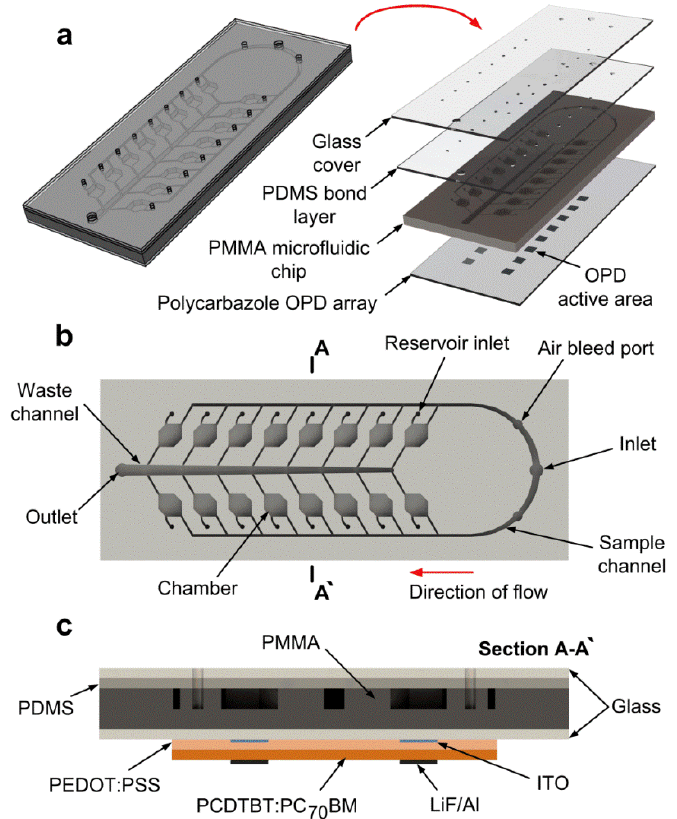
Figure 1. ( a ) Illustration of the multiplexed optical-biosensor platform integrating an array of polycarbazole OPDs to a hybrid microfluidic chip made of PMMA and PDMS. ( b ) Top view of the PMMA microfluidic substrate with ~30 mm 3 volume chambers. ( c ) Cross-section view of the integrated device illustrating all device components (not to